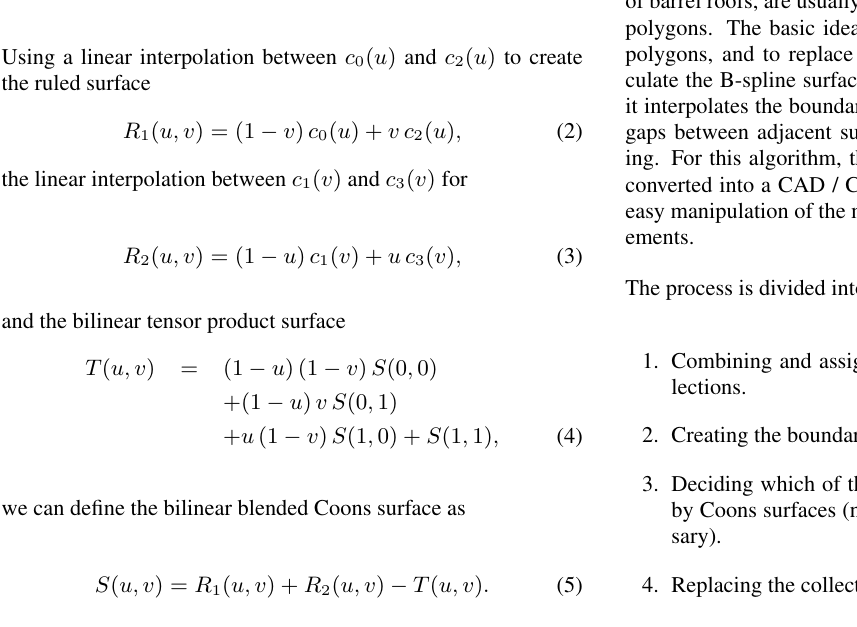
Figure 11. The boundary for a Coons surface given by four B-spline curves